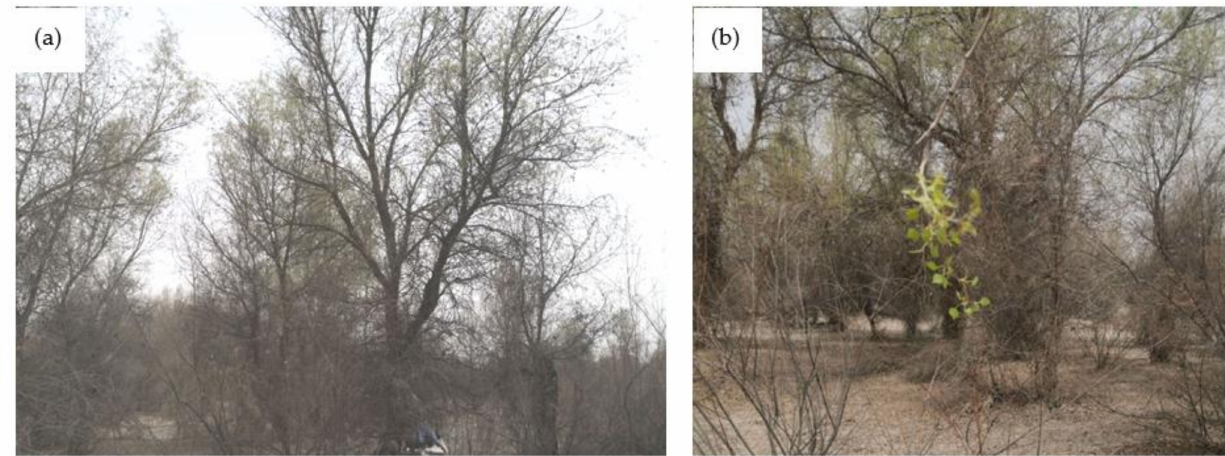
Figure 2. Populus in the leaf development stage, when poplar looper has not yet started chewing on the leaves: ( a ) 23 February 2014, ( b ) 1 March